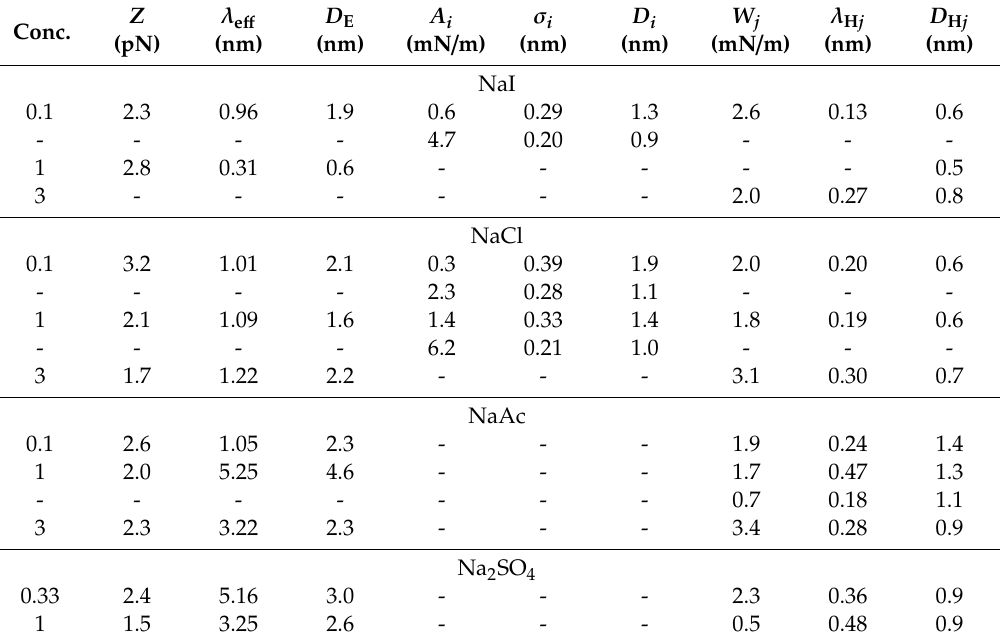
Table 1. Fitting parameters of the F / R vs. D profiles shown in Figure